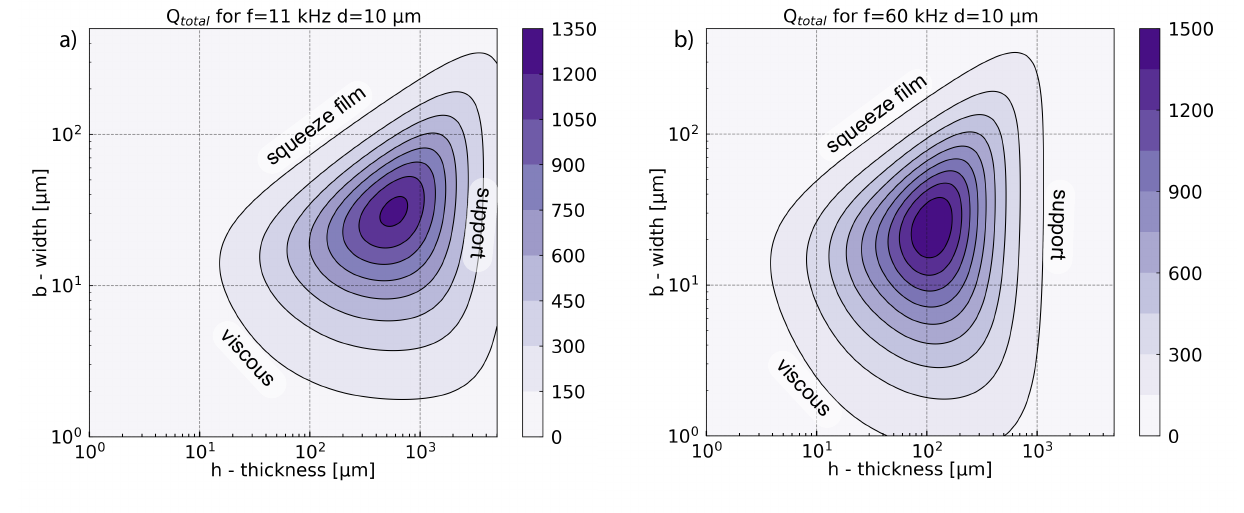
Figure 6. Total quality factor as a function of width and thickness for a cantilever of fundamental resonance frequencies equal to 11 kHz ( a ) and 60 kHz ( b ), for a gap between support and cantilever equal to d = 10 µ